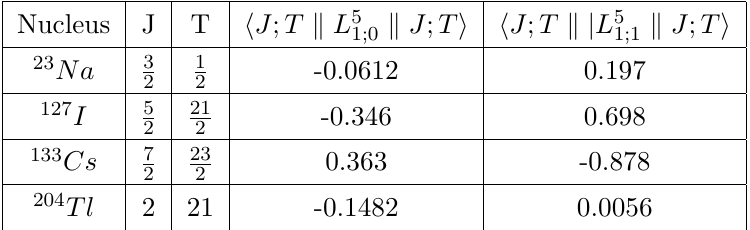
Table 1 . Longitudinal matrix elements from shell model calculations [18, 44] ( Na, I, Cs ) and [45] ( Tl